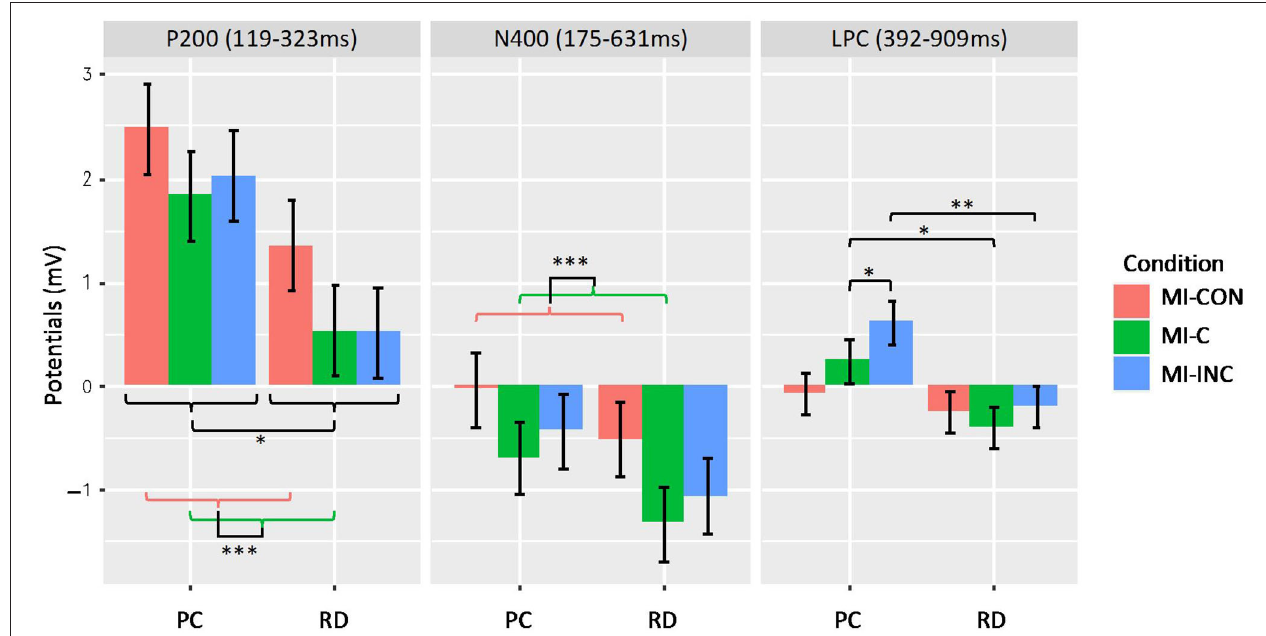
FIGURE 5 | Between-condition contrasts of amplitudes for P200, N400, and LPC for the pre-contemplation (PC) and readiness stage of change group (RD). There was significant main effect of group and condition for P200 potentials, and post-hoc test indicated there was significant differences between Ml-CON and Ml-C. There was significant main effect of condition for N400 potentials, and post-hoc test showed that there was significant differences between Ml-CON and Ml-C. There was significant group-condition interaction effect for LPC. For PC, Ml-INC was more positive than Ml-C. Between PC and RD, Ml-C and Ml-INC were more positive in PC than that of RD. * p < 0.05, ** p < 0.01, *** p <